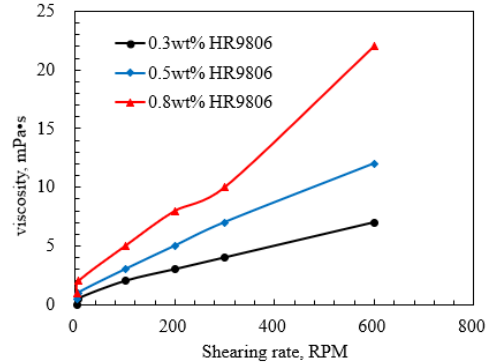
Figure 4. Base fluid viscosity of HR9806 with injected water in North Troyes.